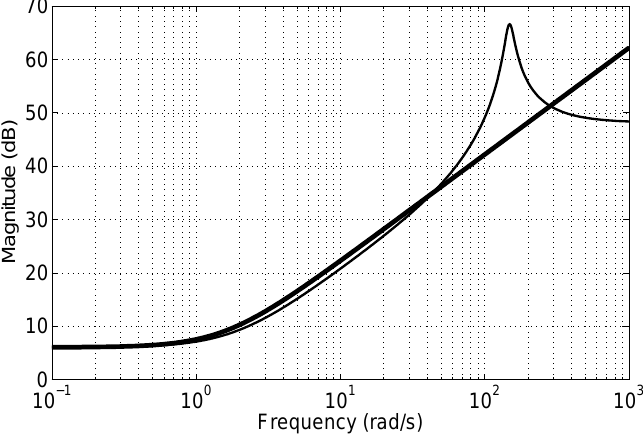
Figure 19. Bode diagram of the actuator impedance (thin line) overlapped with the ideal spring-damper system (thick